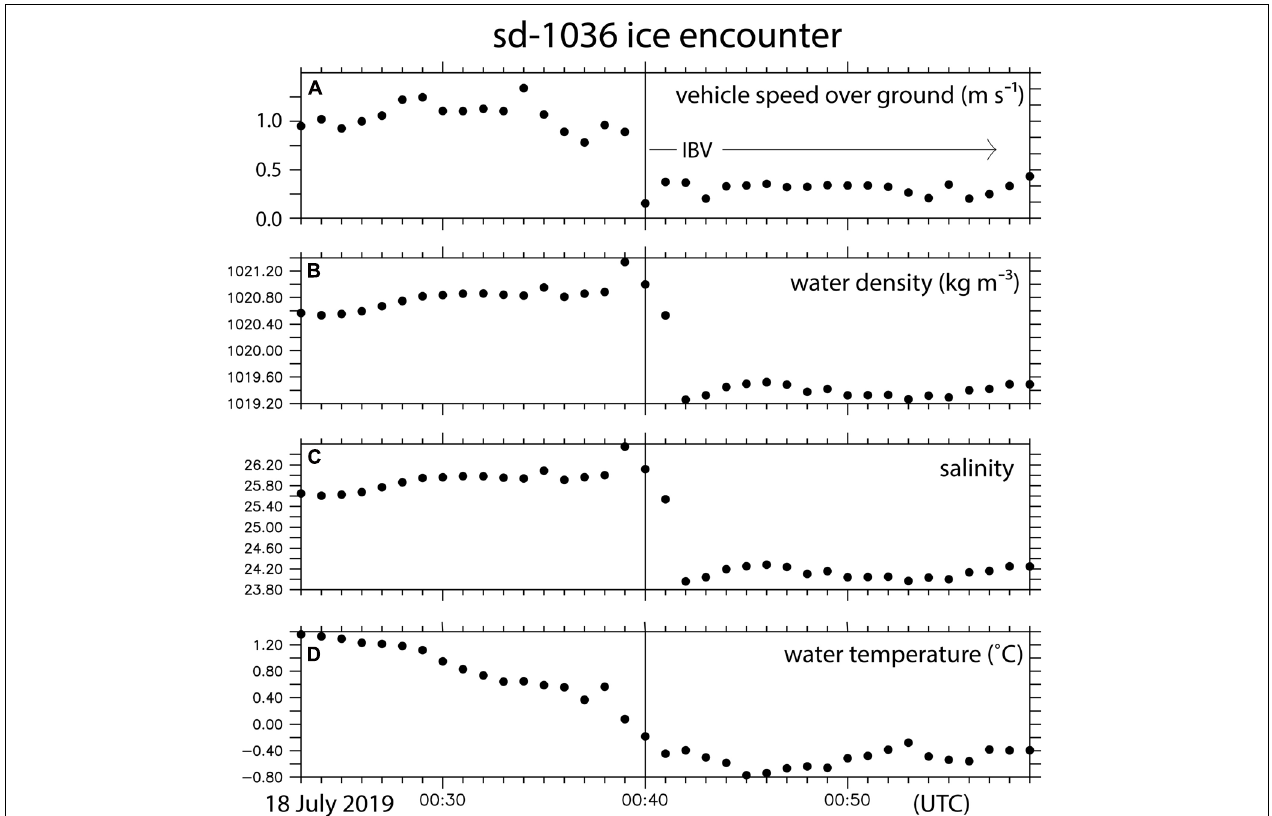
FIGURE 10 | One-minute averaged data just before and after sd-1036 was blocked by sea ice (IBV) on 18 July 2019. (A) The geo-referenced vehicle speed, (B) water density, (C) salinity, and (D) ocean temperature. We infer IBV from the drop in vehicle speed at 00:40 UTC (upper panel; marked with a black vertical line at 00:40 UTC) that sea ice impeded the vehicle’s northward progress sometime between 00:39 and 00:40 UTC. An image confirming that ice was surrounding the vehicle was taken at 00:43 ( Figure 9E